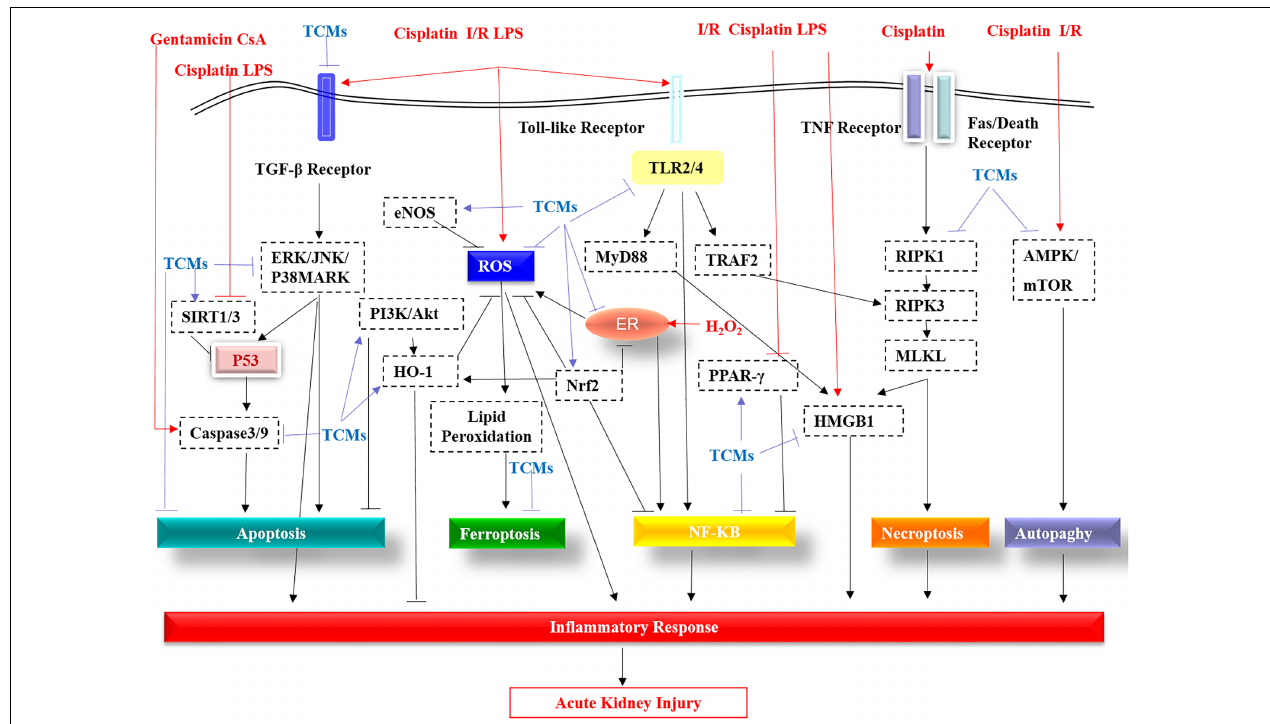
FIGURE 1 | The molecular pathways targeted by the TCMs covered in this review are summarized. TGF- β receptor, Toll-like receptors (TLRs), TNF receptor, and FASL/Death receptors are stimulated by LPS, cisplatin, I/R, etc. These receptors are then activated by the downstream pathway, further triggering ROS production and an inflammatory response, eventually leading to kidney damage. TCMs suppress cisplatin/LPS/I/R-stimulated Toll-like receptors (TLR2/4), or by activating PPAR- γ , further inhibiting the NF- κ B pathway and reducing inflammation. Additionally, apart from targeting caspase3/9, TCMs reduce apoptosis by inhibiting the TGF- β receptor, the ERK/JNK/P38MARK pathway and by promoting PI3K/AKT. In addition, TCMs inhibit autophagy by targeting inhibition of AMPK/mTOR. In addition to the traditional apoptosis, autophagy, programmed necrosis and ferroptosis are also caused during AKI. Wogonin and protocatechuic aldehyde can effectively inhibit RIPK1 in the RIPK1/RIPK3/MLKL of necroptosis. TLR2/4-mediated TRAF2 has a stimulant effect on RIPK3. Induction of HMGB2 by necroptosis and TLR2/4-regulated MyD88 aggravates the inflammatory response of acute kidney injury, while TCMs significantly improve this phenomenon via direct or